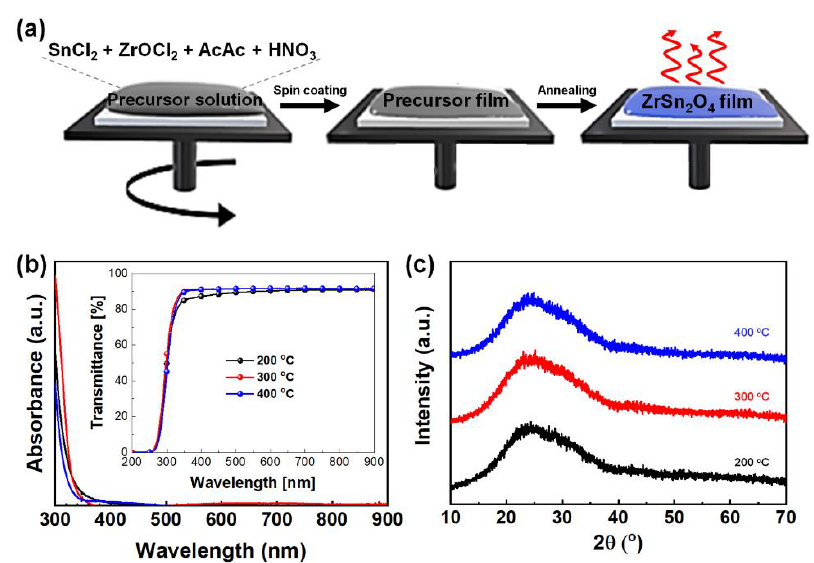
Figure 1. Synthetic scheme ( a ), absorption spectra ( b ), and X-ray diffractograms ( c ) of ZrSnO 4 films prepared by sol-gel method.